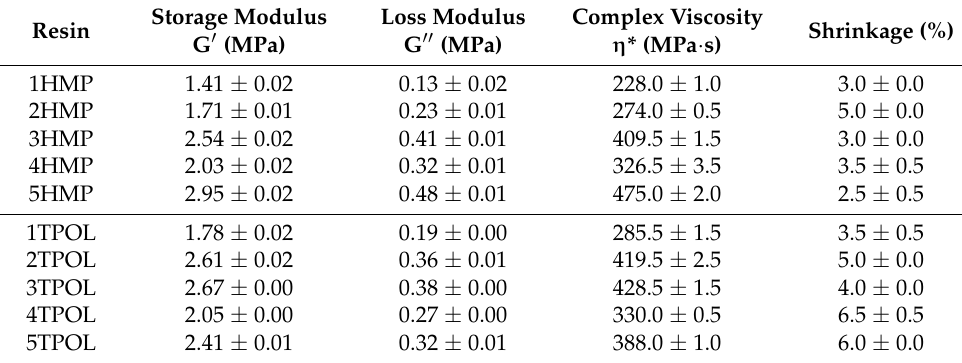
Table 1. Rheological characteristics and shrinkage of AESO thiol–ene resins.